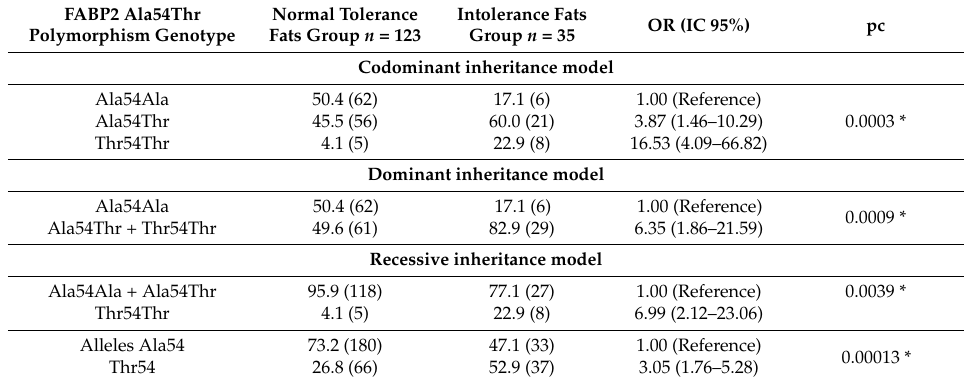
Table 2. FABP2 genotype and alleles frequencies in individuals with fat tolerances and fat